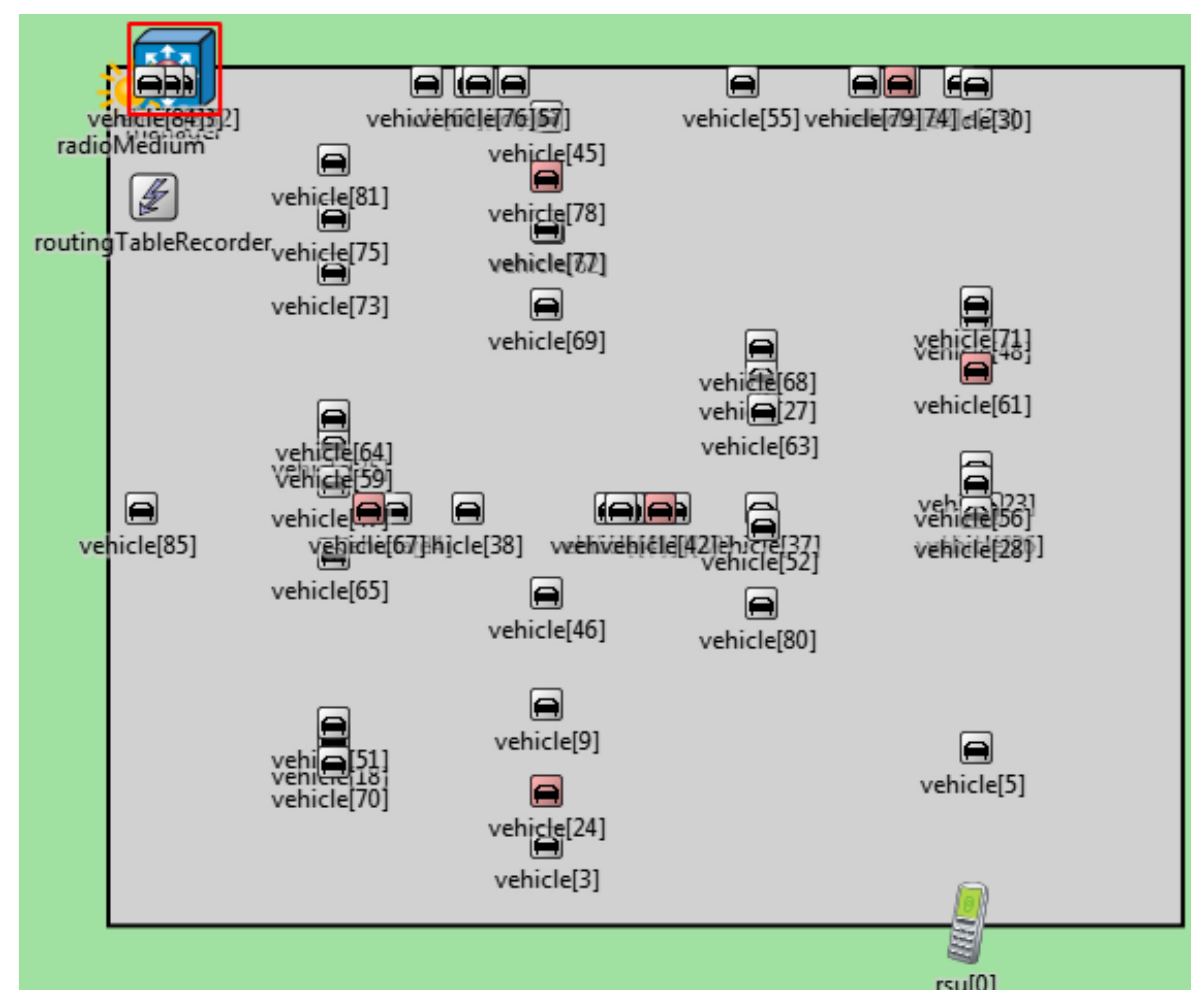
Figure 9. Simulation scenario. Table 5. Performance values comparison under Jellyfish periodic drop